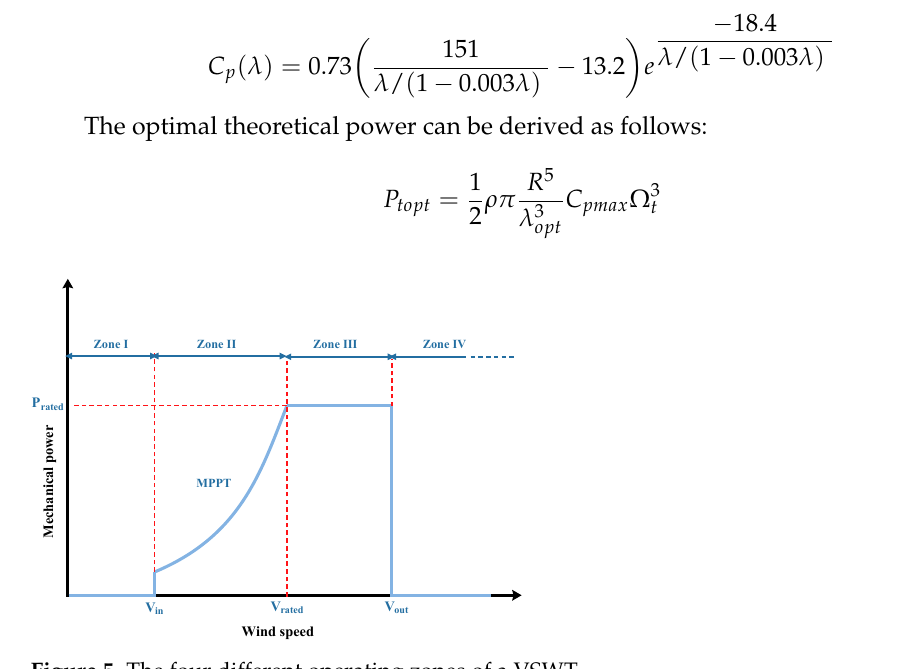
Figure 5. The four different operating zones of a